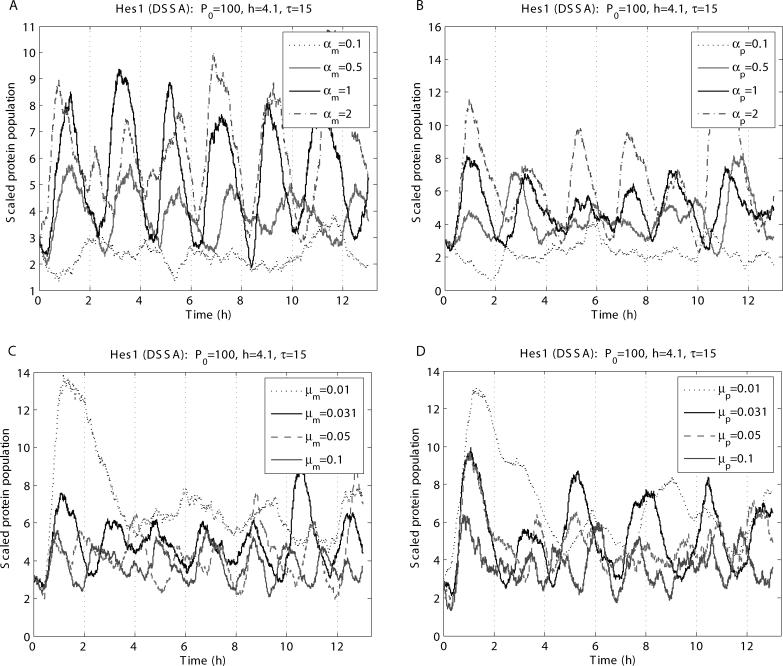
Sensitivity Analysis: DSSA Simulations with Perturbed Rate Constants(A) αm
.
(B) αp
.
(C) μm
.
(D) μp.